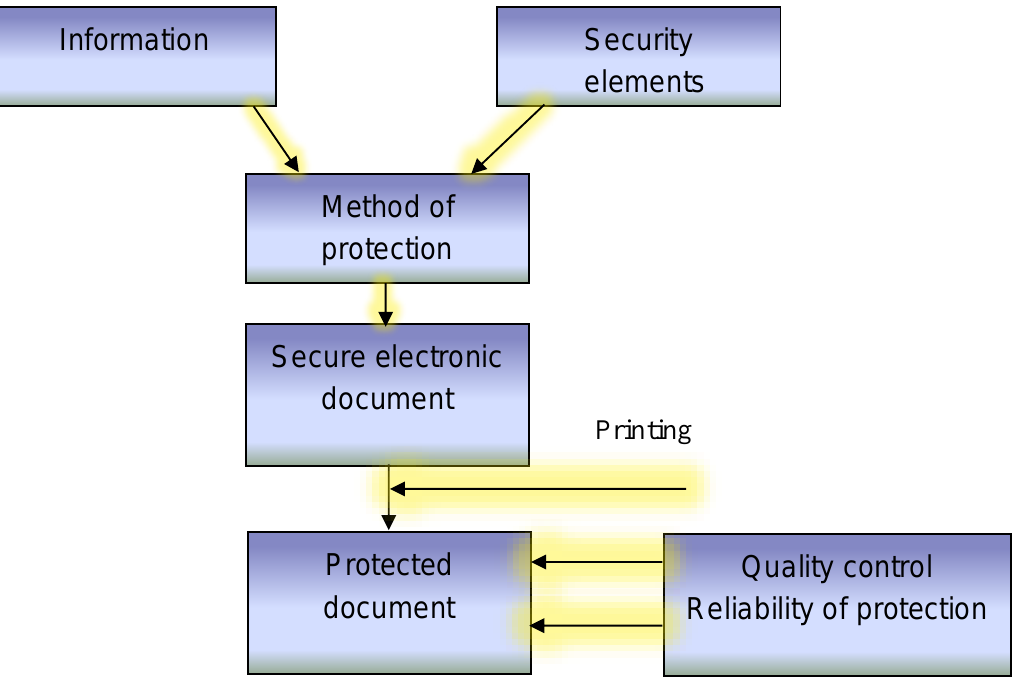
Figure 2. Flowchart of information technology for protection for printed